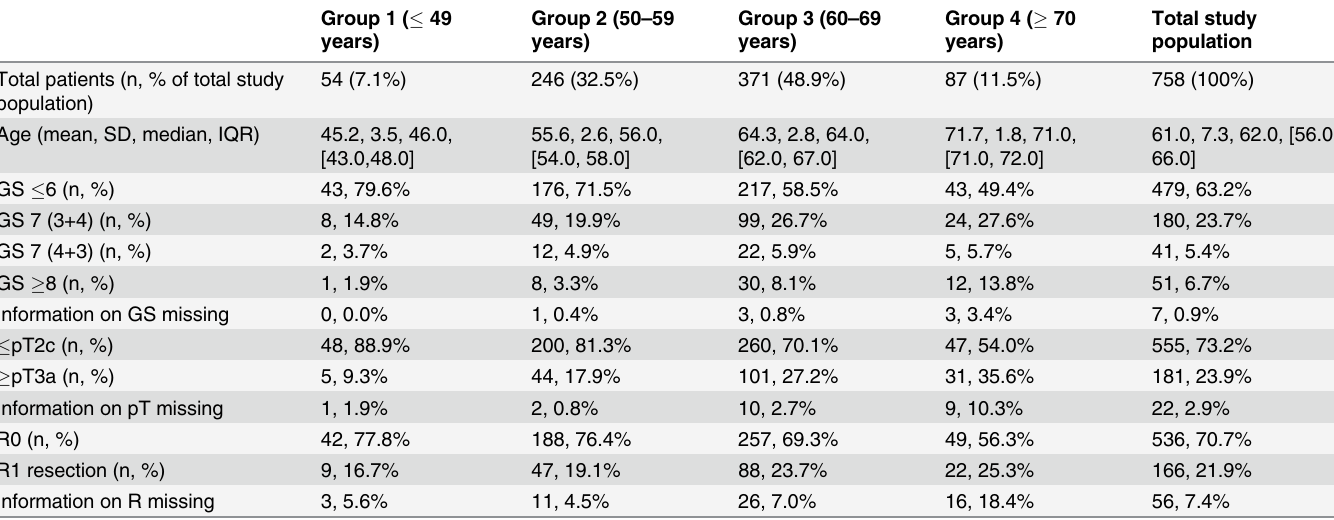
Table 2. Histopathological characteristics of radical prostatectomy specimens stratified by